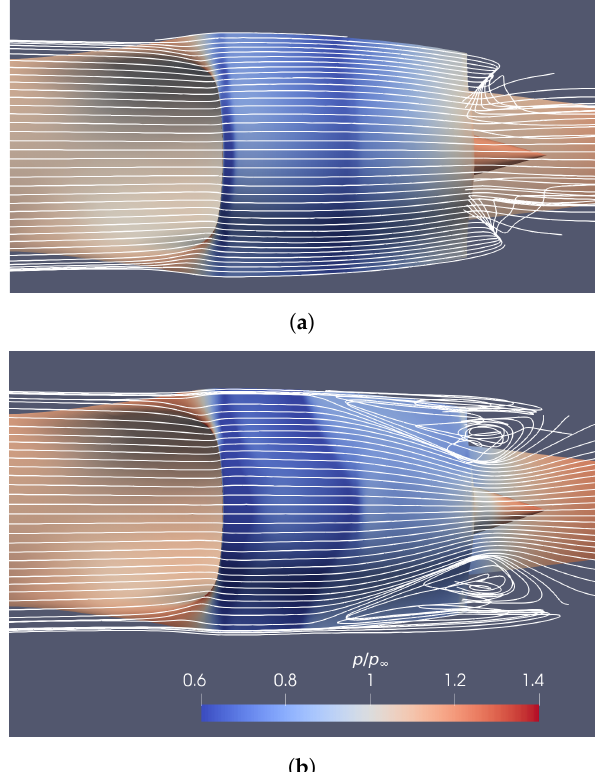
Figure 10. Top view showing surface static pressure p / p ∞ and the streamlines over the cowl. ( a ) Case I. ( b ) Case II.